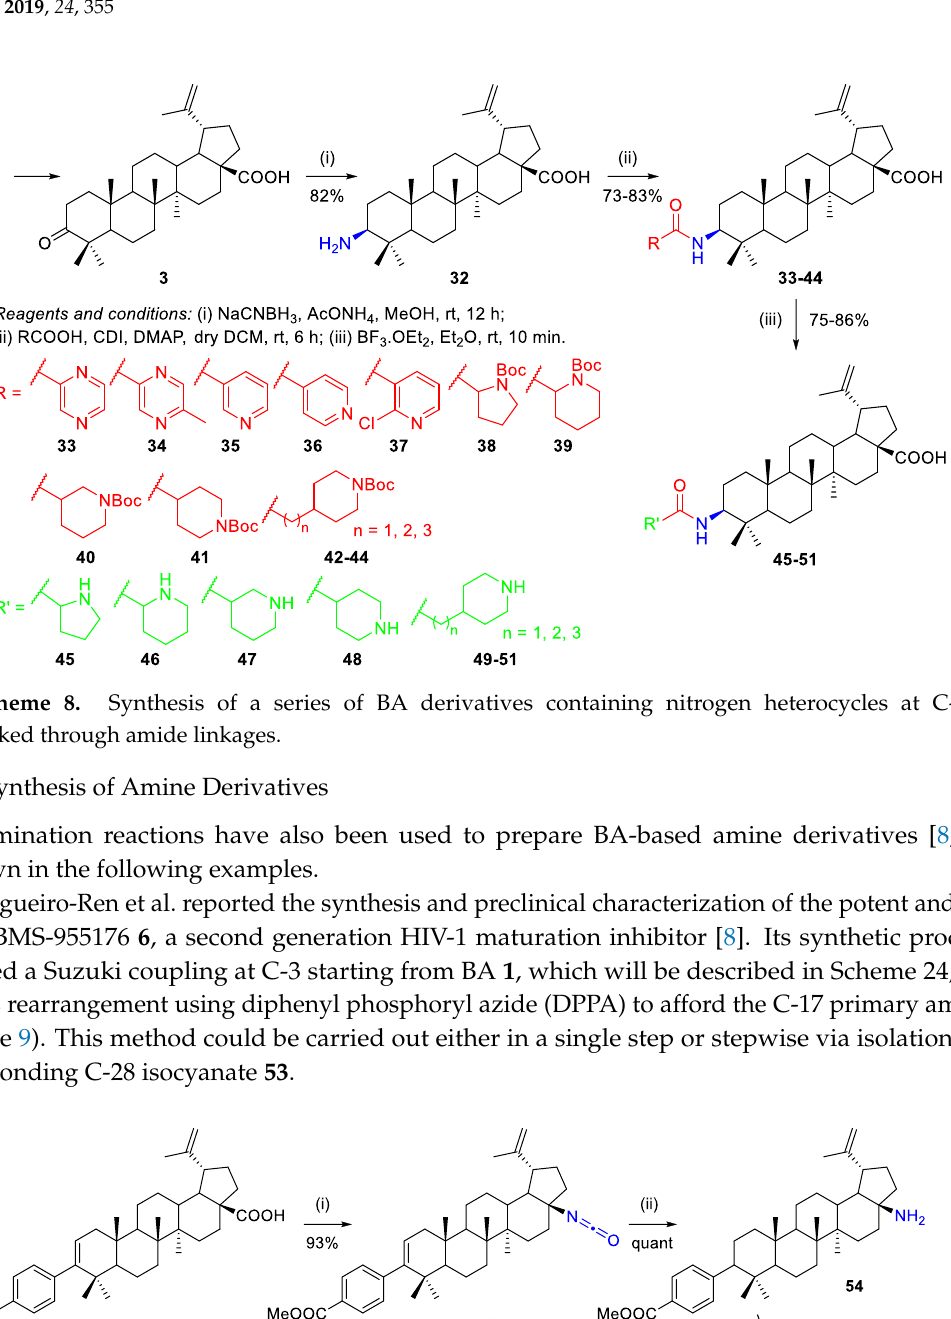
Molecules 2019 , 24 , x 6 of 33 Scheme 6. BA-based amide derivative 25 as intermediate in the synthesis of triazole-bridge d β - CD‒ BA conjugates. Scheme 7. Synthesis of bevirimat derivatives 28 – 31 . A different methodology was employed to prepare BA-based amide derivatives at C-3 [31]. The key intermediate 32 , a BA-based primary amine, was obtained in very good yield (82%) by Borch reduction of BoA 3 with sodium cyanoborohydride and ammonium acetate in methanol (Scheme 8). Then, the authors found that N , N’ -carbonyldiimidazole (CDI) was the optimal condensation agent and provided compounds 33 – 37 and intermediates 38 – 44 in good yields (73% – 83%).